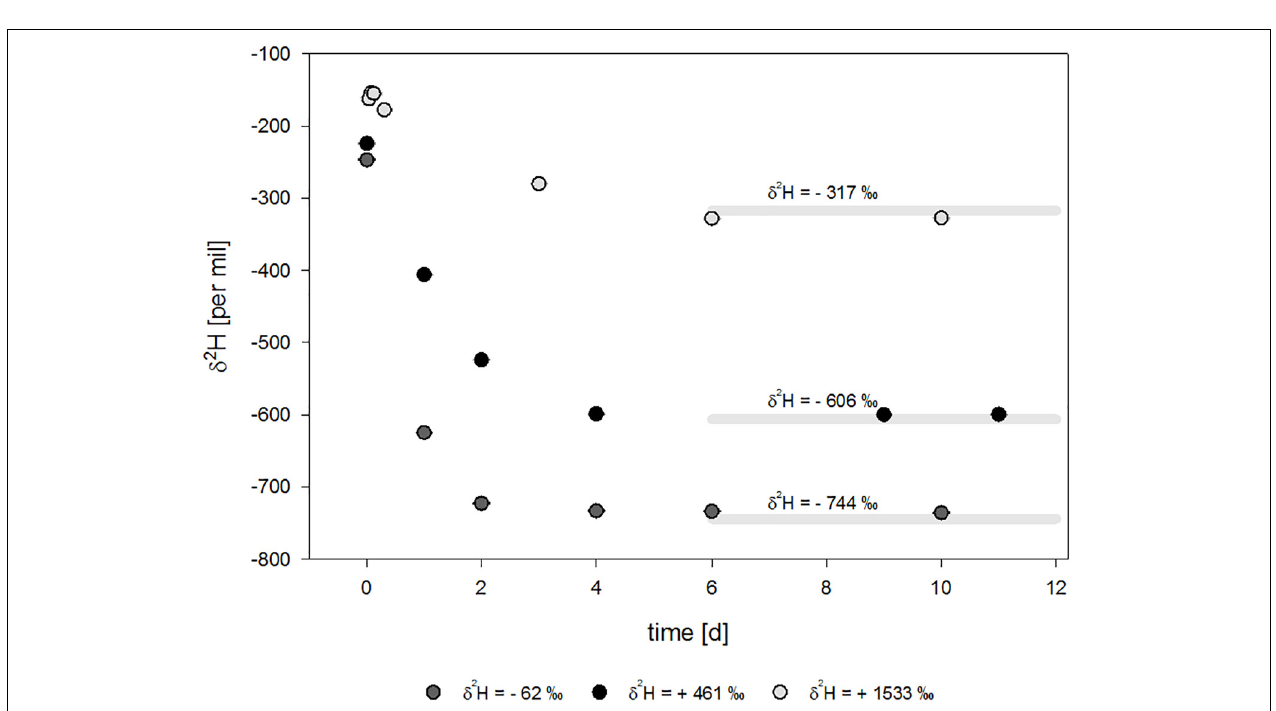
(A) or with δ 2 H 2 O = +461 (B) . The isotope equilibrium is (cid:104) (cid:104)